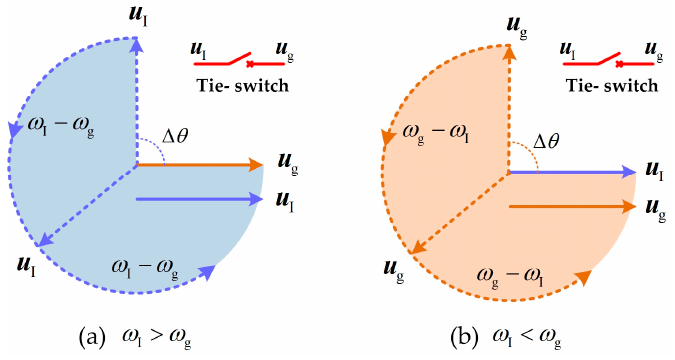
Figure 4. Principles of distant synchronization.